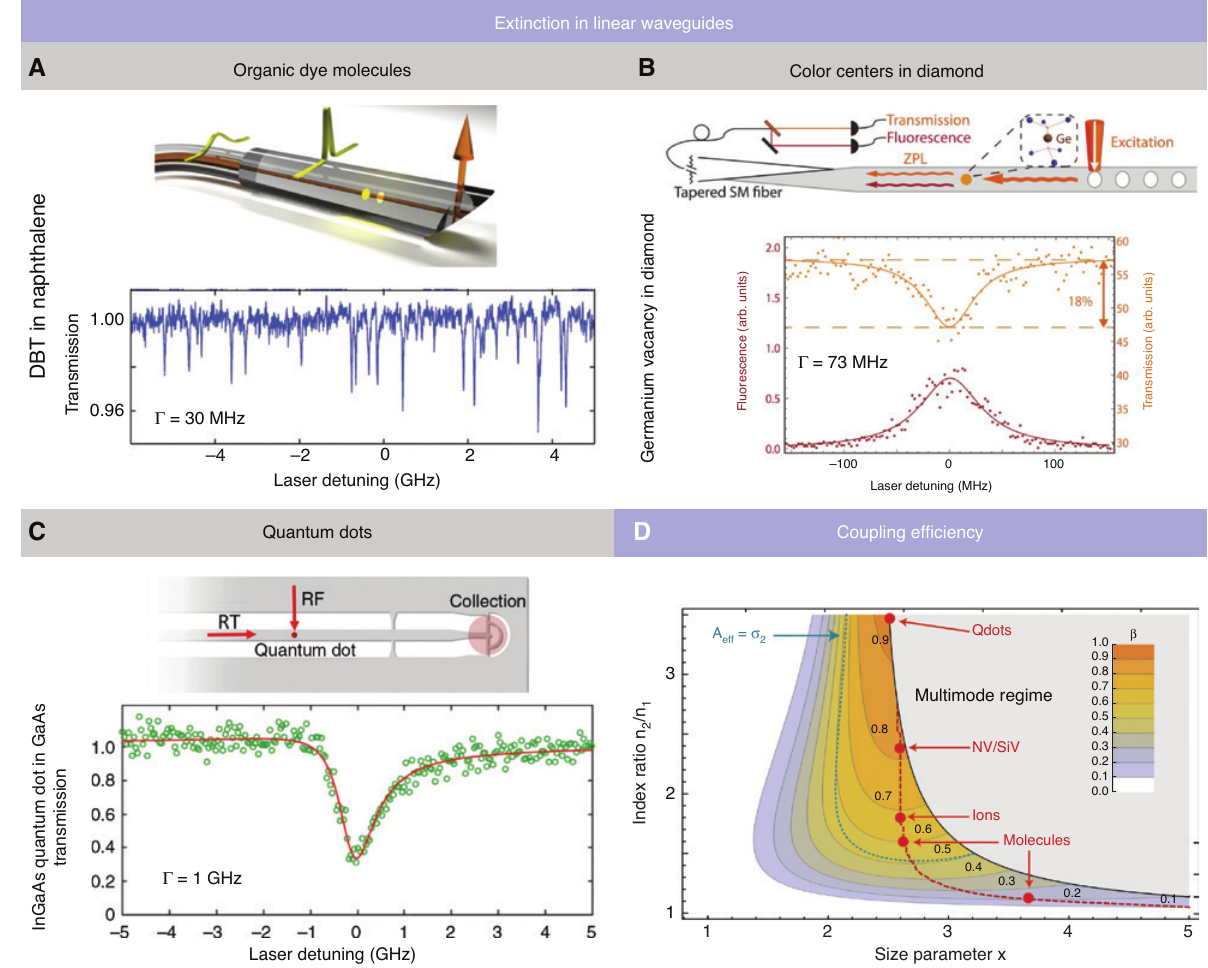
Figure 2: State-of-the-art coherent extinction with a variety of solid-state quantum emitters in differing nanoguide geometries, including (A) single organic molecules, (B) Ge defects in diamond, and (C) InAs quantum dots. Adapted from [22], [28], and [64], respectively. (D) Maximum achievable coupling coefficient β for cylindrical nanoguides of different core sizes and the refractive index contrast surrounding the core. The core size is parameterized by the unitless variable x = k r , where k is the wavenumber of light in the bulk material of the core 2 2 and r is the radius of the nanoguide. Achievable β -factors for the different solid-state quantum emitters are marked in red symbols (dashed red line denotes the optimal achievable β for a given refractive index contrast), as is the geometry for which the effective mode area is equal to the scattering cross-section of an emitter (dashed blue